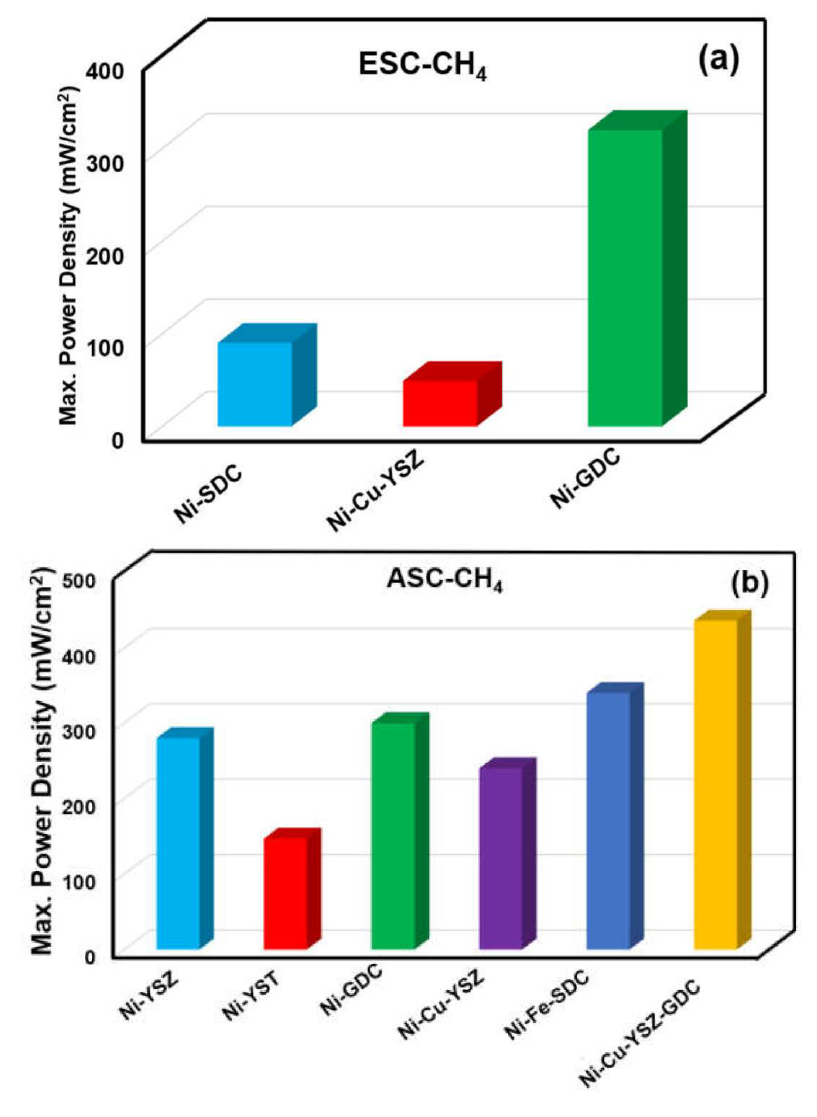
Figure 12. Performance of Ni cermet anodes in ( a ) ESC and ( b ) ASC operated with CH 4